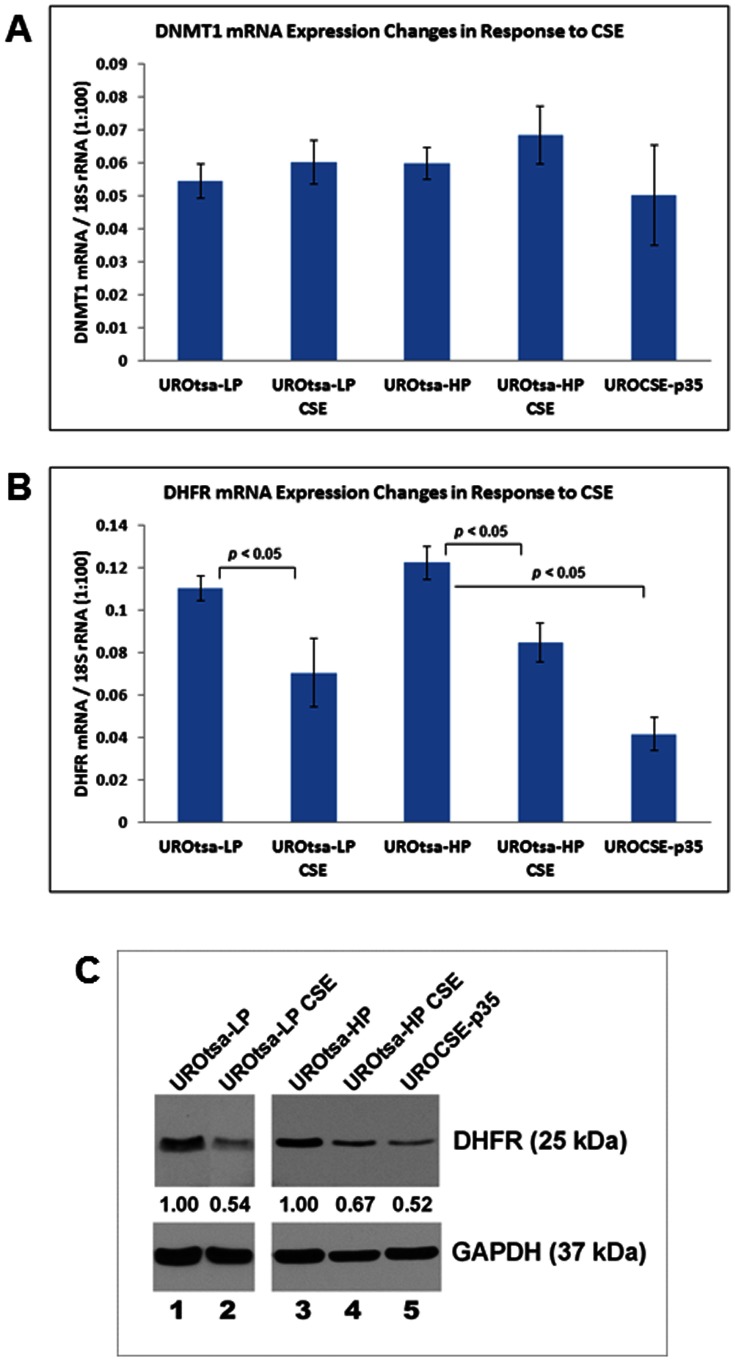
Changes of DNMT1 and DHFR expression in the CSE-treated UROtsa cells.A. DNMT1 mRNA expression in UROtsa cells transiently or chronically treated with CSE. Data represent DNMT1 mRNA copy numbers relative to 1/100 of the 18S rRNA copy number, determined as the mean of three independent experiments with standard errors shown by the error bars. UROtsa-LP: UROtsa cells cultured in CSE-free medium, 8th passage; UROtsa-LP CSE: UROtsa-LP cells treated for 1 day with CSE. UROtsa-HP: UROtsa cells cultured in CSE-free medium, 34th passage; UROtsa-HP CSE: UROtsa-HP cells treated for 1 day with CSE. UROCSE-p35: UROtsa cells chronically treated with CSE, 35th passage. B. DHFR mRNA expression in UROtsa cells transiently or chronically treated with CSE. Statistically significant differences between the datum columns are as indicated in the figure (n = 3, p<0.05). C. DHFR protein expression in UROtsa cells transiently or chronically treated with CSE. The images presented here represent the results from three independent experiments. For samples in Lanes 1 and 2, 40 µg of total protein were loaded in each lane; for samples in Lanes 3–5, 15 µg of total protein were loaded in each lane. After normalizing the DHFR signal intensities to the corresponding GAPDH signal intensities, the relative DHFR signal intensity in the untreated cells was assigned as 1.00 and the relative DHFR signal intensities of the CSE-treated cells are as indicated in the figure.